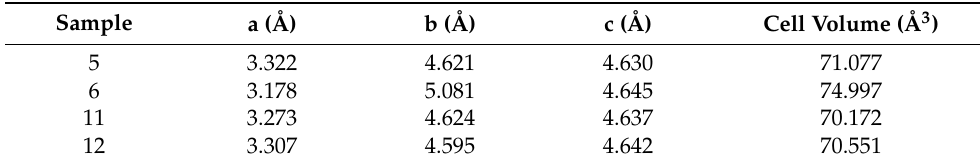
Figure 8. XRD patterns of samples 1, 2, 5, 6, 11 and 12 (grazing incidence angle). Table 6. Lattice parameters of orthorhombic α″ cell.